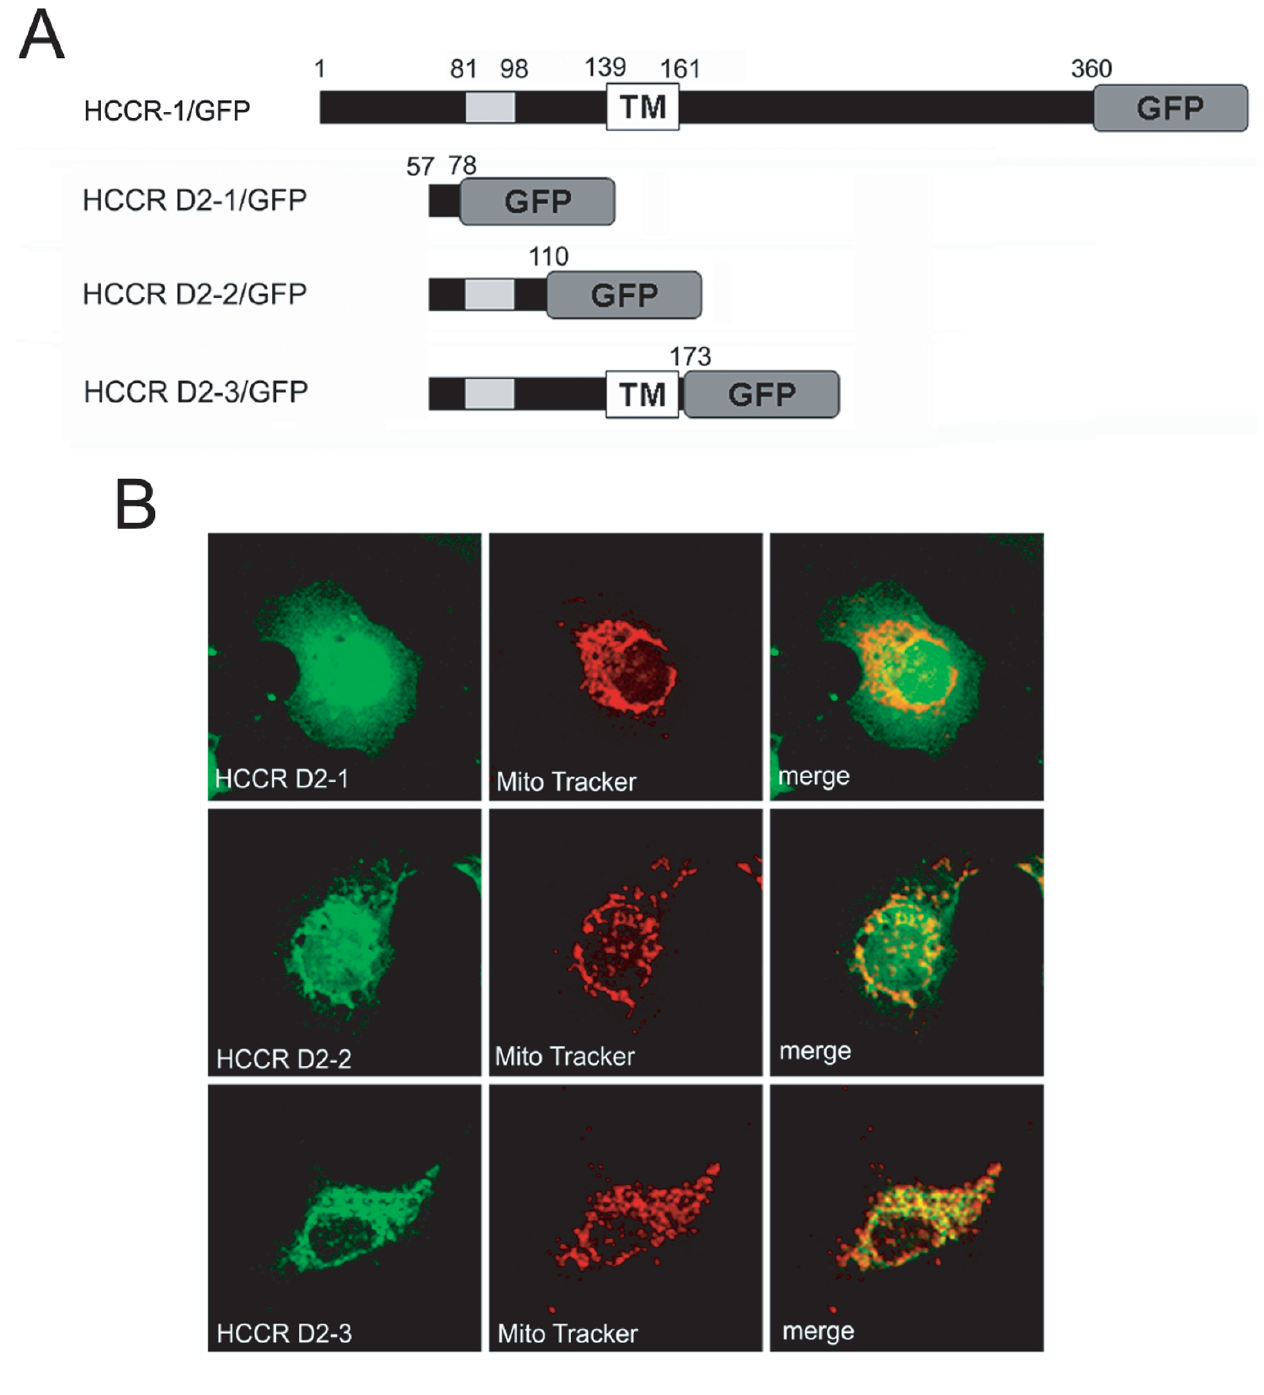
Figure 4 Mitochondrial targeting of HCCR-1 requires the D1-2 region . (A) Schematic structure of HCCR-1 deleted mutants which were COOH-terminally linked by the GFP reporter gene. Grey boxes indicate the hydrophobic region. TM boxes indi- cate the locations of putative transmembrane domain. (B) Expression of deleted mutants in COS-7 cells. COS-7 cells were transfected with the indicated constructs in the expression vectors. Other conditions were same as in Figure